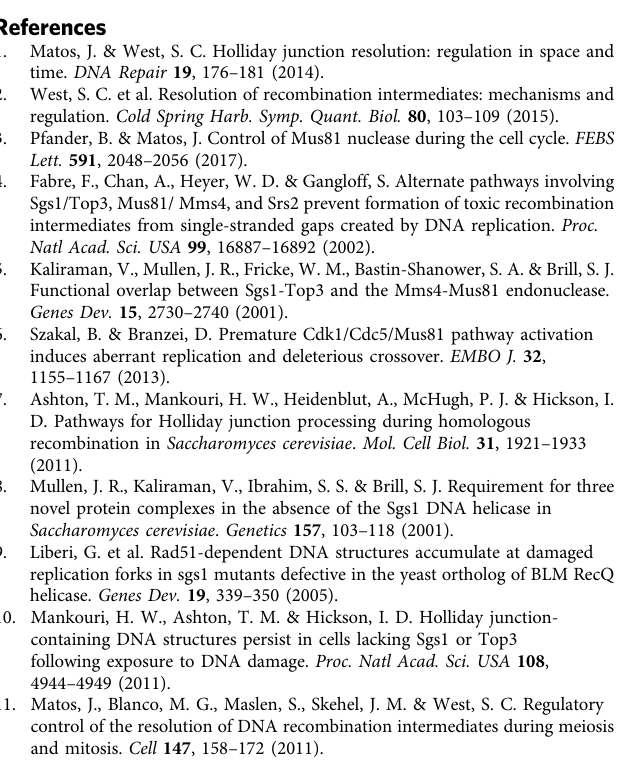
signi fi cant. Pulldown experiments (Figs. 2 and 3 and Supplementary Figs. 3 and 8) were repeated at least twice and one representative western blot was selected for the fi gure. 2D gel experiments were repeated at least twice and, in some cases, addi- tionally different alleles or regions were used to con fi rm the results.